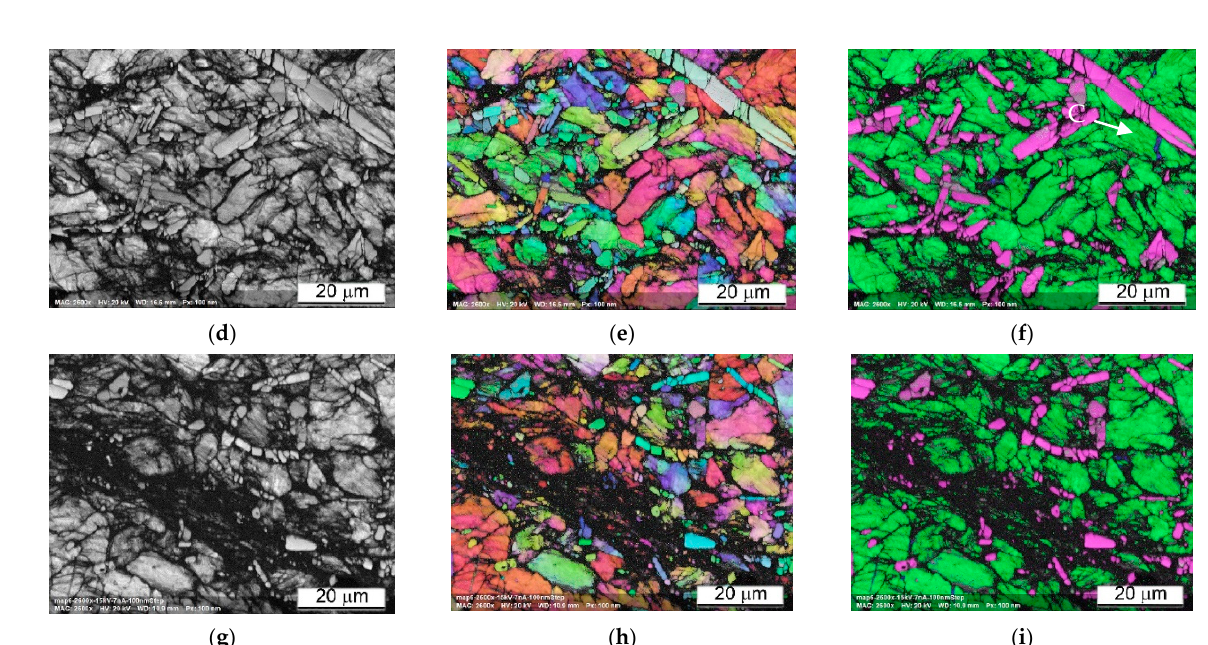
Figure 18. SEM EBSD images of Ti64BEPM + 10TiB sample after SHPB test with rate 2510 s − 1 . The sample stays unbroken after the test, but forms the ASB area in the Zone II (Figure 8). Pattern Quality Maps ( a , d , g ); orientation maps ( b , e , h ) phase maps ( c , f , i ) images. The green color in phase map images represents α -phase, blue β -phase, and magenta TiB particles.